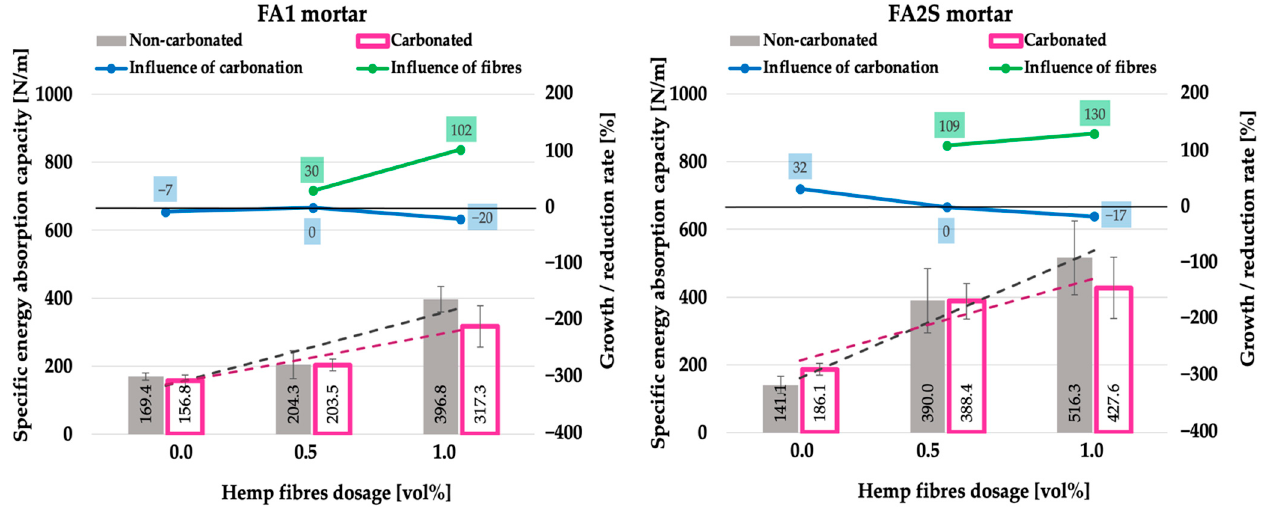
Figure 7. Specific energy absorption capacity of fly-ash-based (FA1) and fly-ash-and-slag-based (FA2S) mortars prior to [26] and after accelerated carbonation.